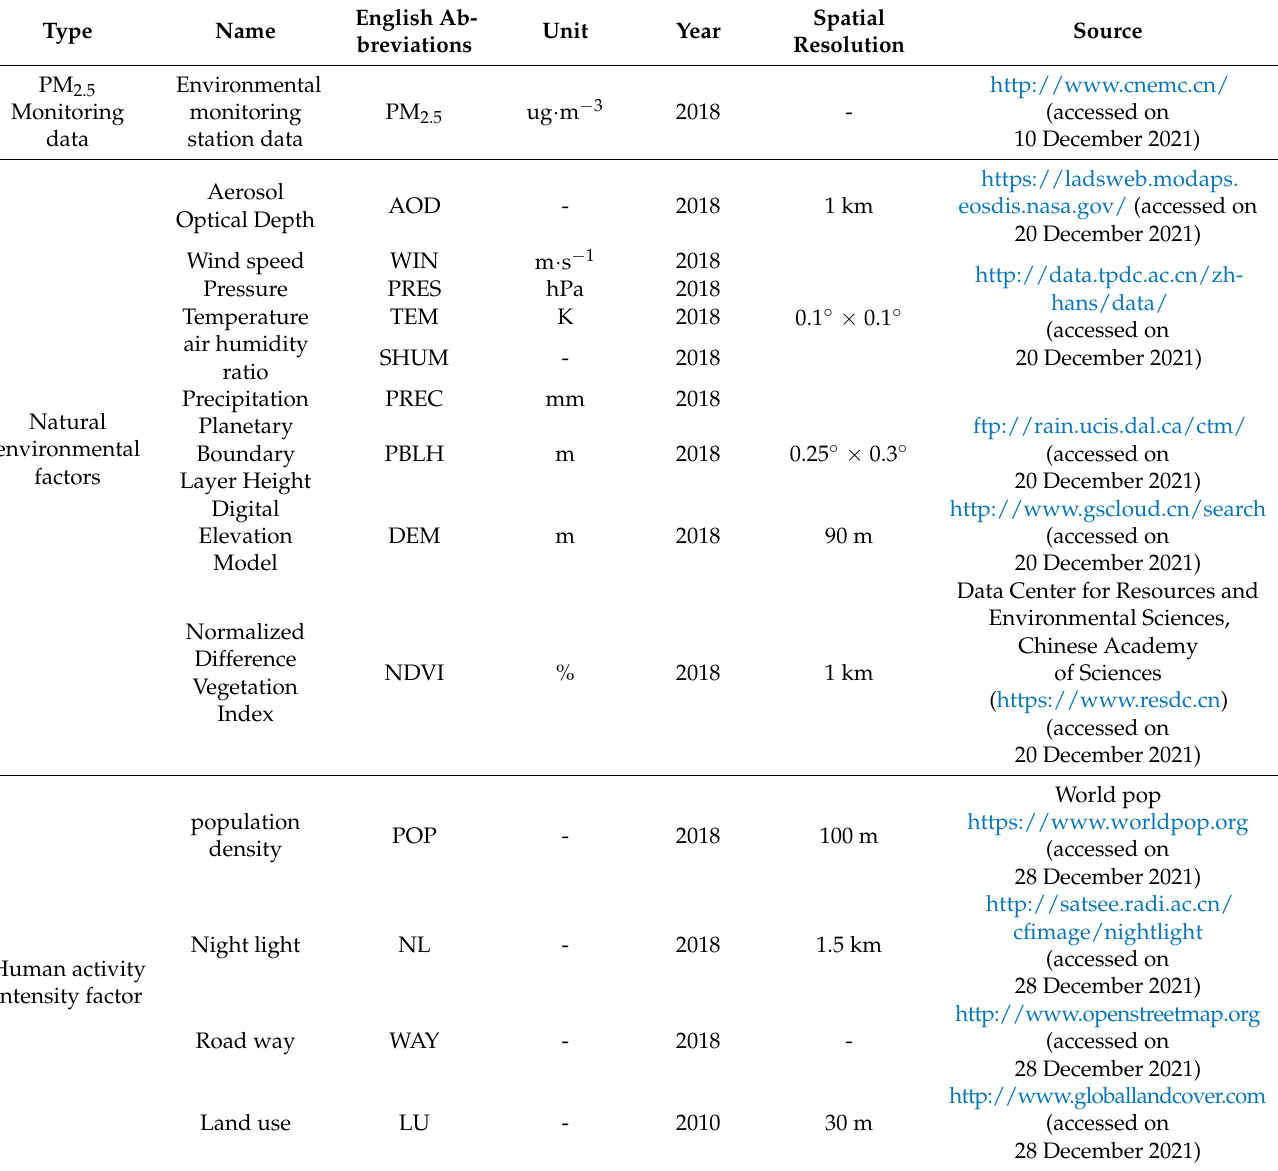
Table 1. Data sources for